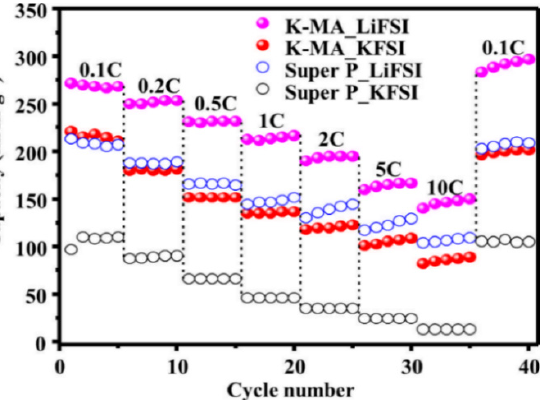
Figure 4. Rate capabilities of K − MA_LiFSI, K − MA_KFSI, SP_LiFSI, and SP_KFSI measured at various rates from 0.1C to10C.